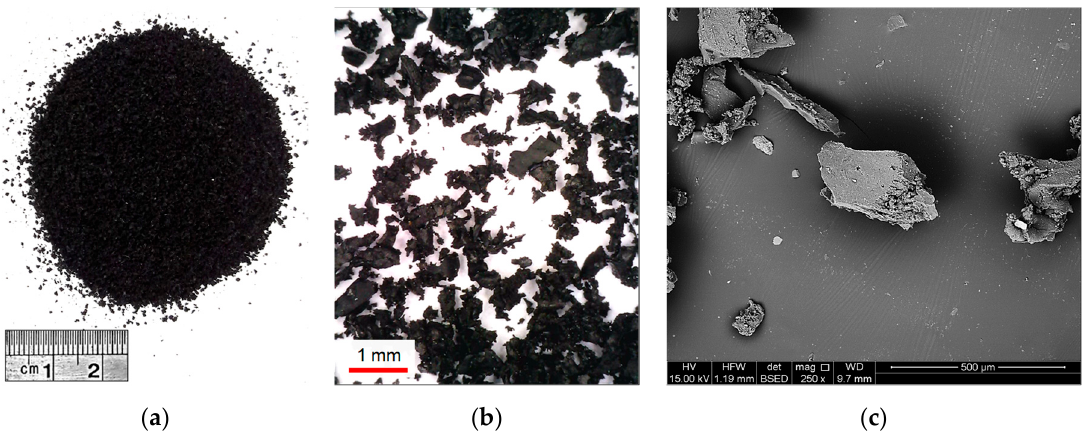
Figure 1. GR material at various magnification ratios: ( a ) 1× magnification; ( b ) 50× magnification (via optical microscopy); and ( c ) 250× magnification (via SEM).